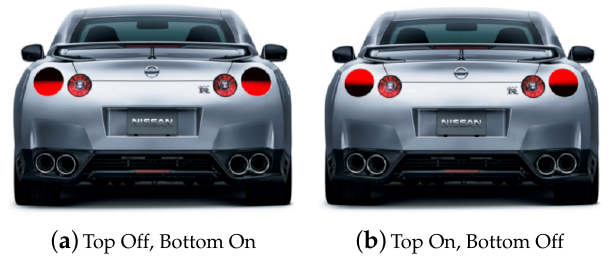
Figure 9. Captured image with ambiguous states of the taillights